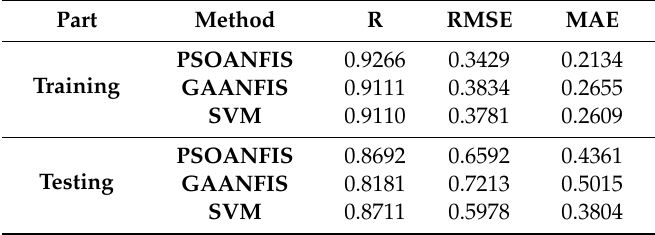
Figure 6. Correlation results of actual and predicted the MS for: ( a ) training PSOANFIS; ( b ) testing PSOANFIS; ( c ) training GAANFIS; ( d ) testing GAANFIS; ( e ) training SVM and ( f ) testing SVM. Table 5. Summary of prediction capability for the training and testing parts using PSOANFIS, GAANFIS and